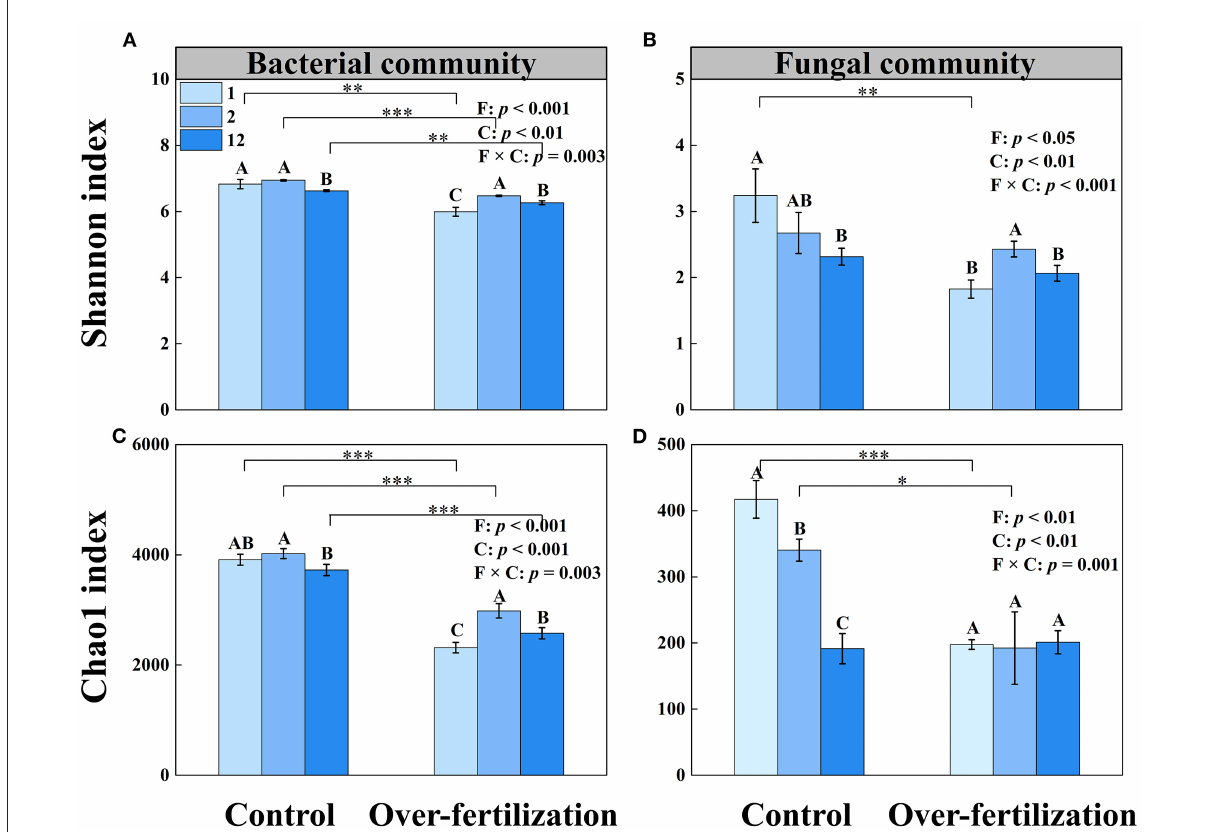
FIGURE3 Effects of fertilization on soil microbial α -diversity under tomato cropping. (A) The variations of bacterial Shannon index. (B) The variations of fungal Shannon index. (C) The variations of bacterial Chao1 index. (D) The variations of fungal Chao1 index. Values are means ± SD ( n = 3). * , ** , and *** indicate significant differences between fertilization under the same cropping duration at p < 0.05, p < 0.01, and p < 0.001, respectively. Different letters (A, B, and C) above the bars indicate significant ( p < 0.05) differences between cropping durations under the same fertilization treatments. F, fertilization; C, cropping